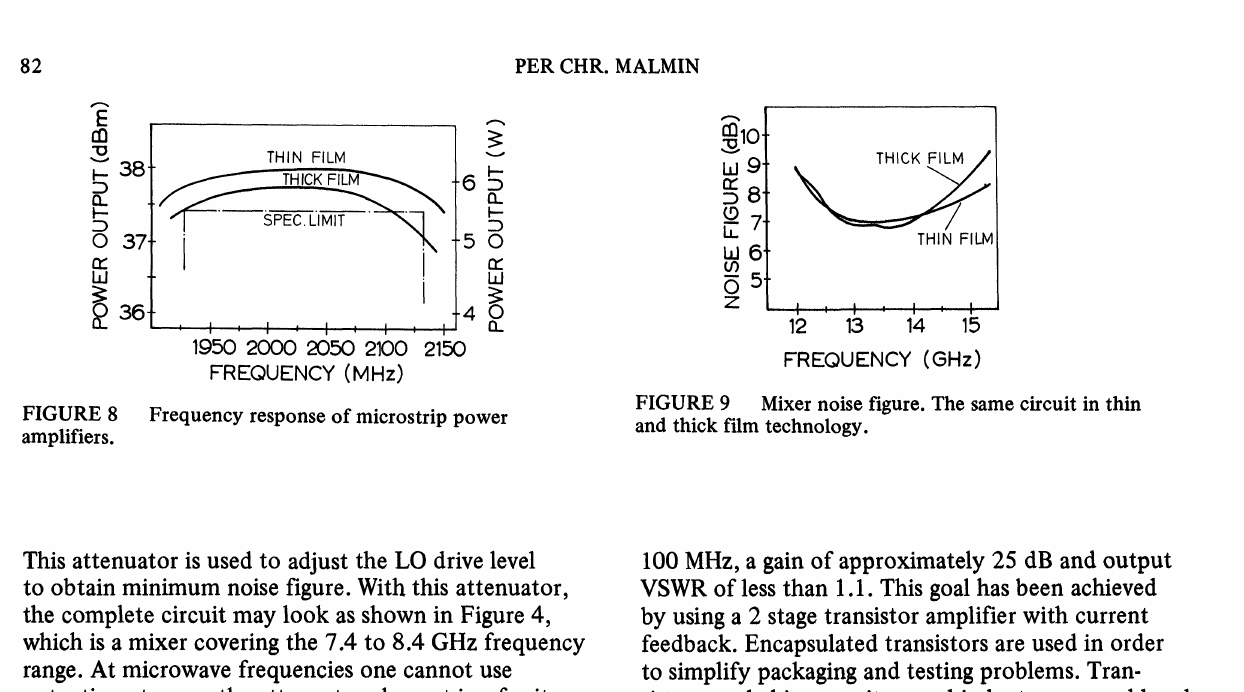
FIGURE 8 amplifiers.